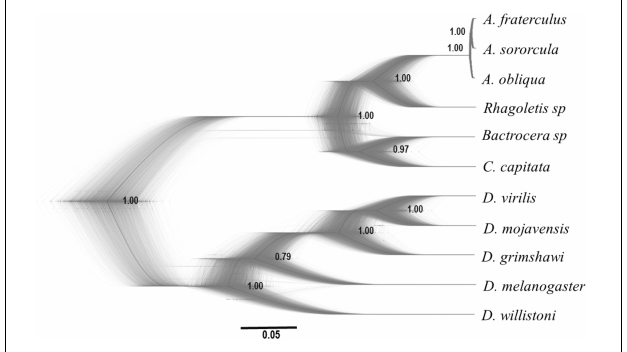
FIGURE 2 | Density species tree obtained by ∗ BEAST analysis using all 20 genes, showing posterior probabilities for each node. Branch lengths are proportional to genetic